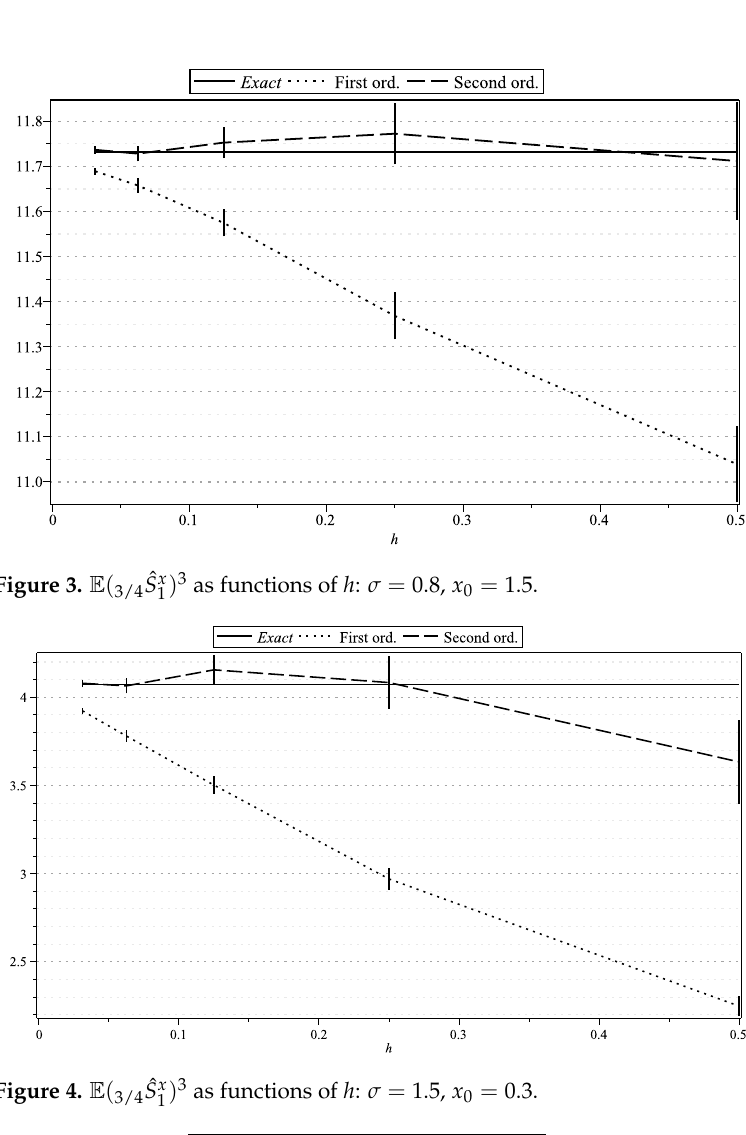
Figure 4. E ( 3/4 ˆ S x